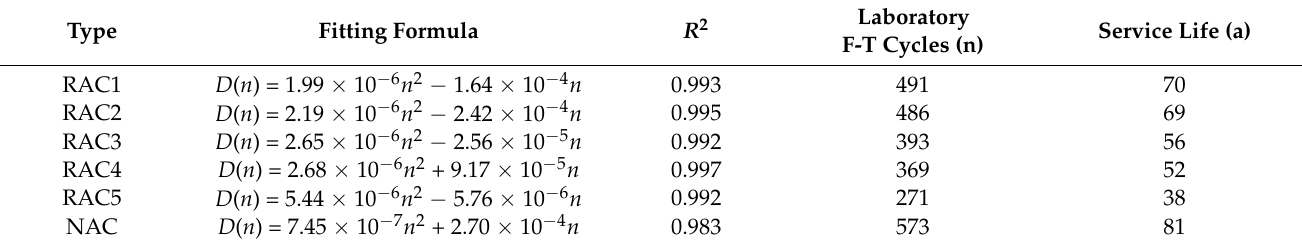
Figure 11. The variations of F-T damage of RAC- i. Table 4. The fitting formula, laboratory F-T cycles, and service life in cold